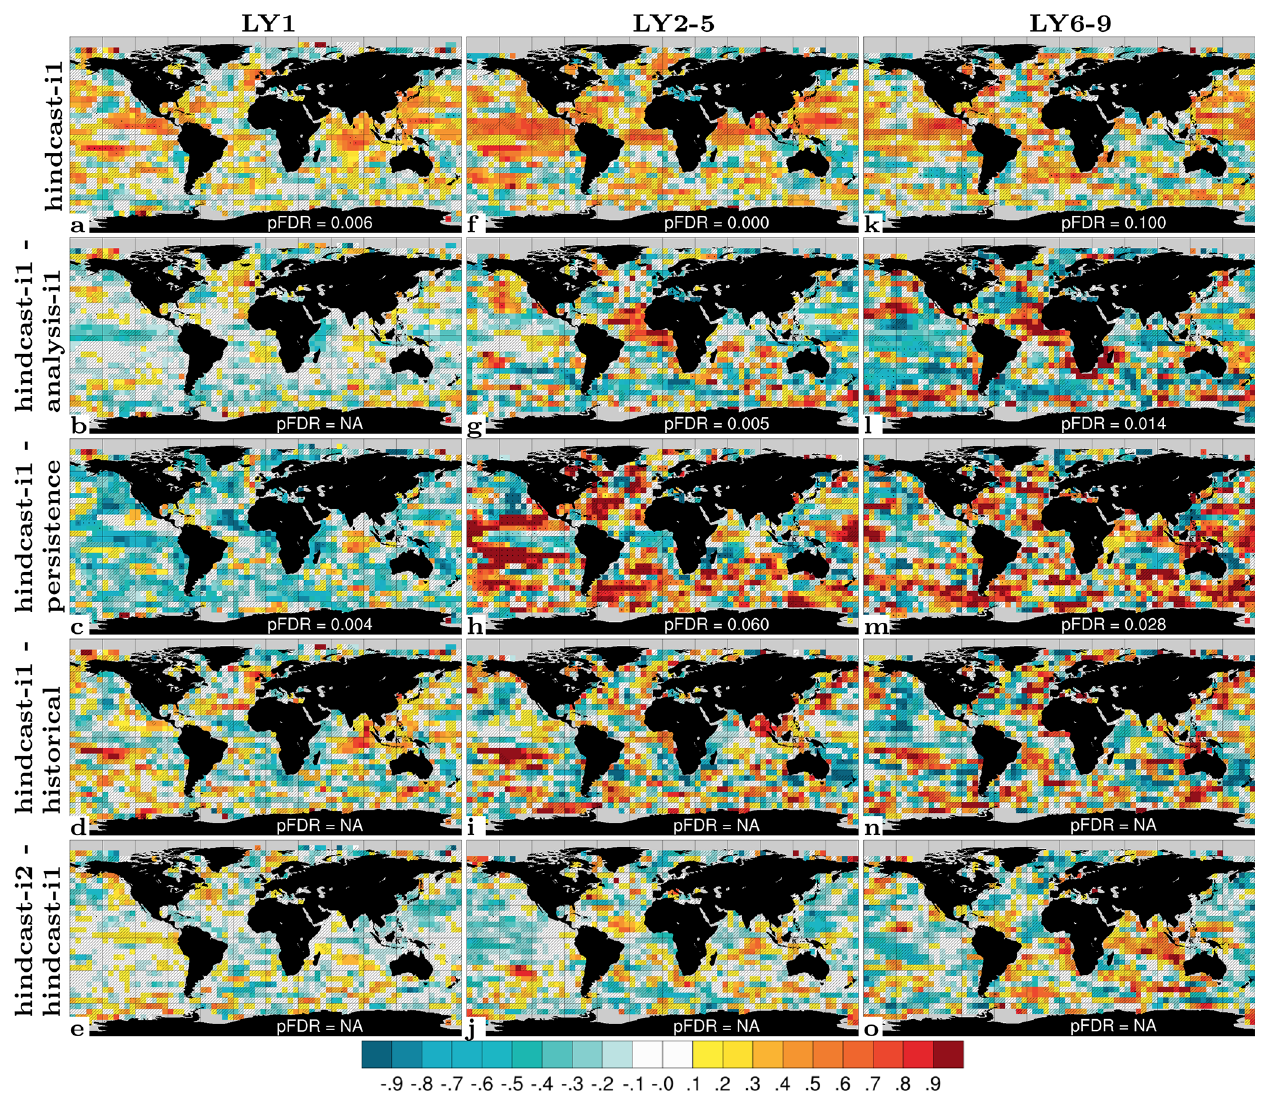
Figure 14. Prediction skill for PP. ACC of hindcast-i1 (a) , (cid:49) ACC of hindcast-i1 – analysis-i1 (b) , (cid:49) ACC of hindcast-i1 – persistence (c) , (cid:49) ACC of hindcast-i1 – historical (d) and (cid:49) ACC of hindcast-i2 – hindcast-i1 (e) for LY1. The middle and right columns show the same but for LY2–5 (f–j) and LY6–9 (k–o) . Observations use GlobColour (Garnesson et al., 2019) with coverage for 1998–2018. Hatched areas are not locally significant; dotted areas are field